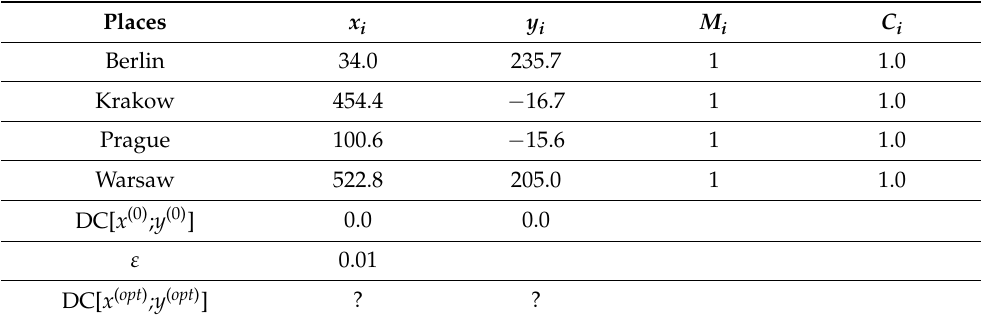
Table 1. Input data for calculating the DC location, DC[ x ( opt ) ; y ( opt ) ], point coordinates, unit quantities, unit prices, and selected